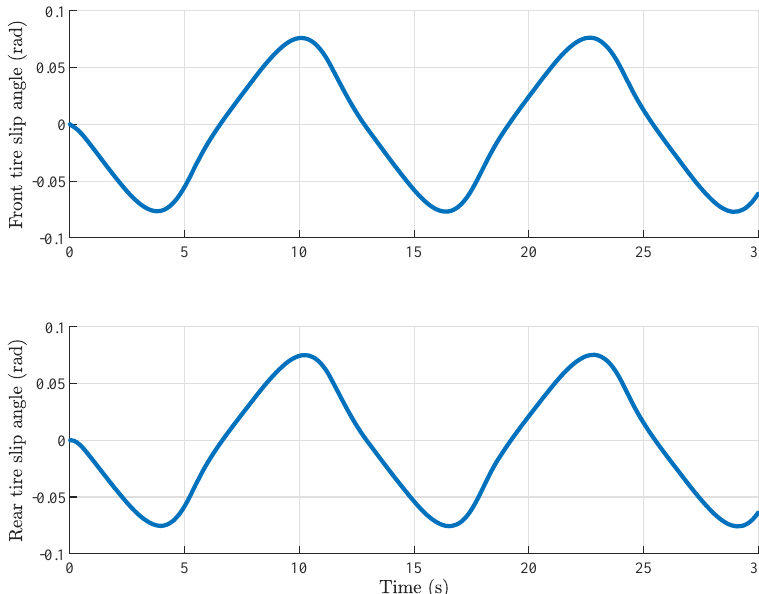
Figure 17. Evolution of slip angle of DMDc-MPC (Case 3).